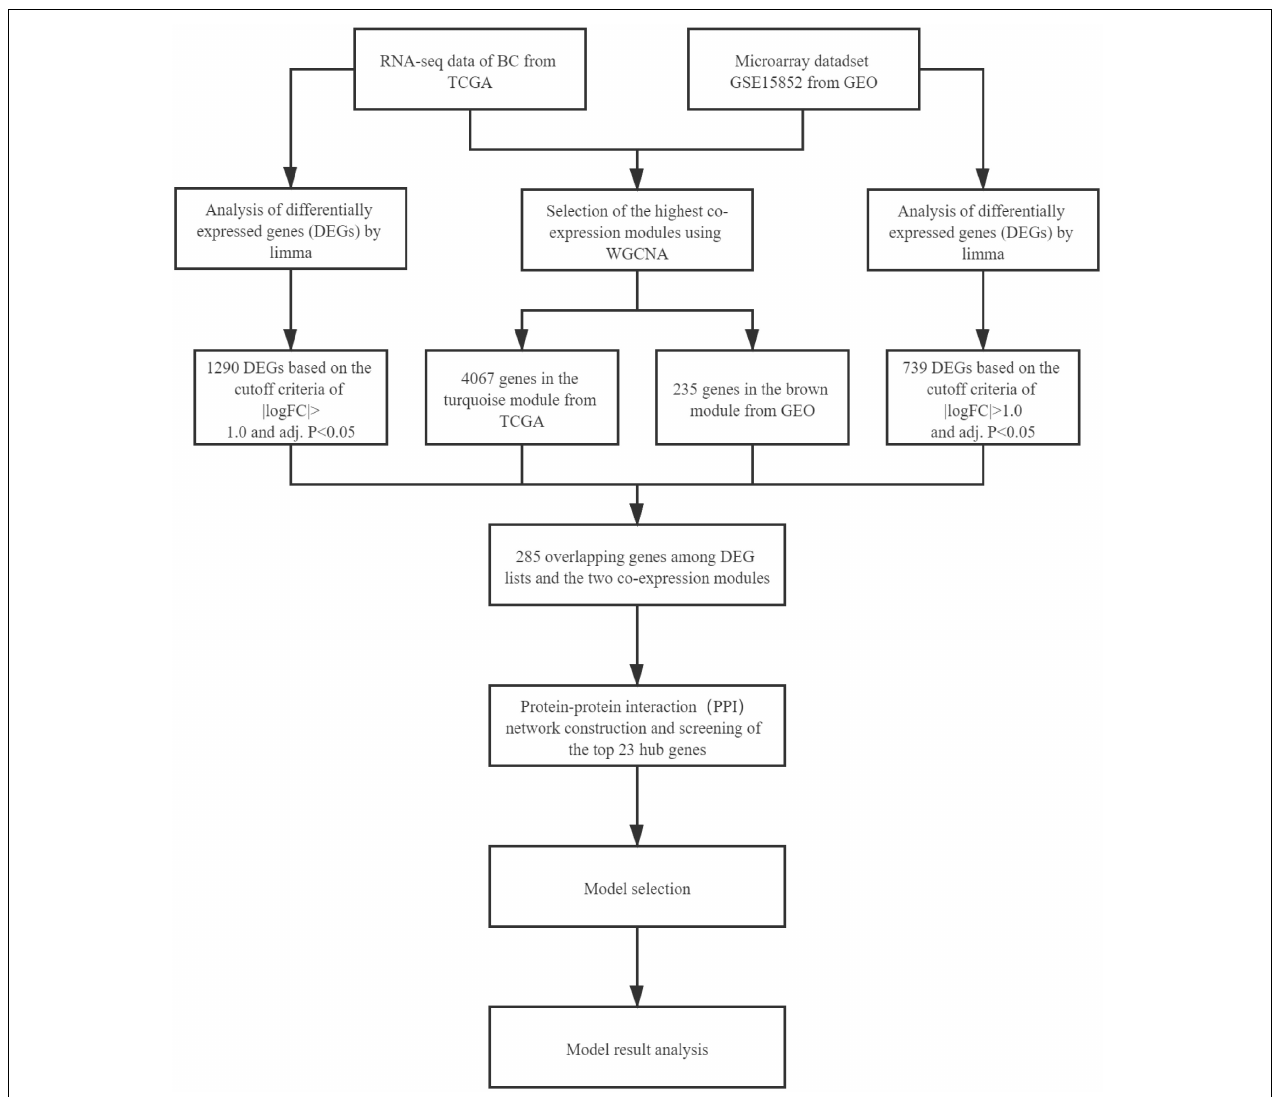
FIGURE 1 | Workflow of this